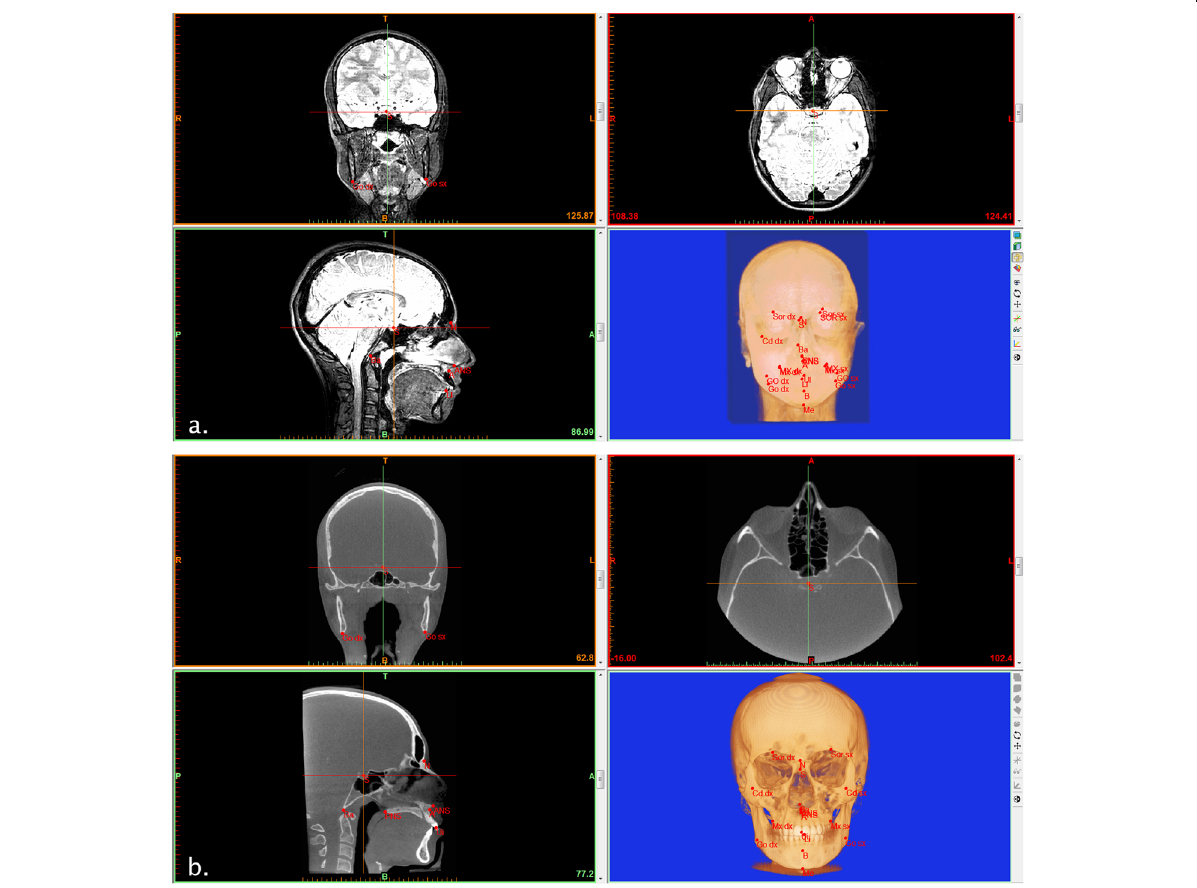
Fig. 2 Multiplanar reconstruction and 3D reconstruction views after landmark identification. a Snapshot of software interface, showing 3T-MRI cephalometric landmarks on axial, coronal, and sagittal sections and on 3D volumetric rendering. b Snapshot of the software interface, showing CBCT cephalometric landmarks on axial, coronal, and sagittal sections and on 3D volumetric